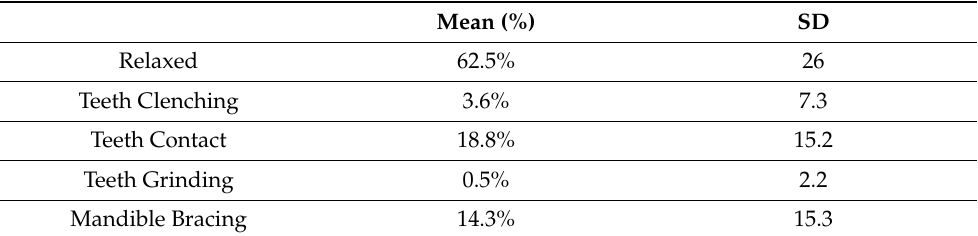
Table 3. Frequency of each condition recorded with the Ecological Momentary Assessment (EMA) over the 7-day observation period. Data are shown as mean percentages ± standard deviation